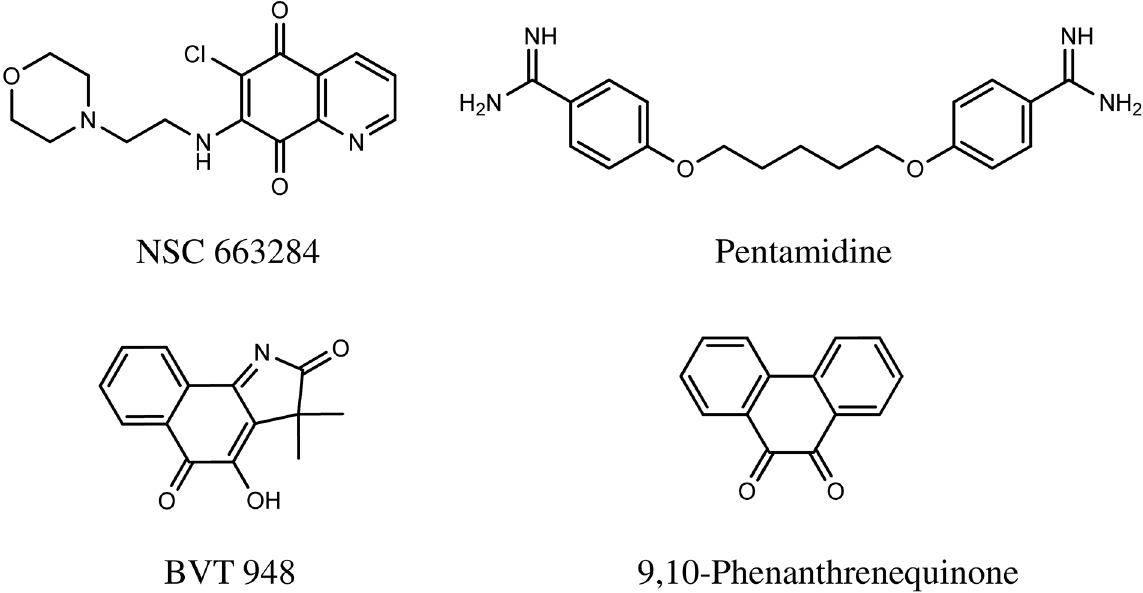
Fig 2. The chemical names and structures of the identified